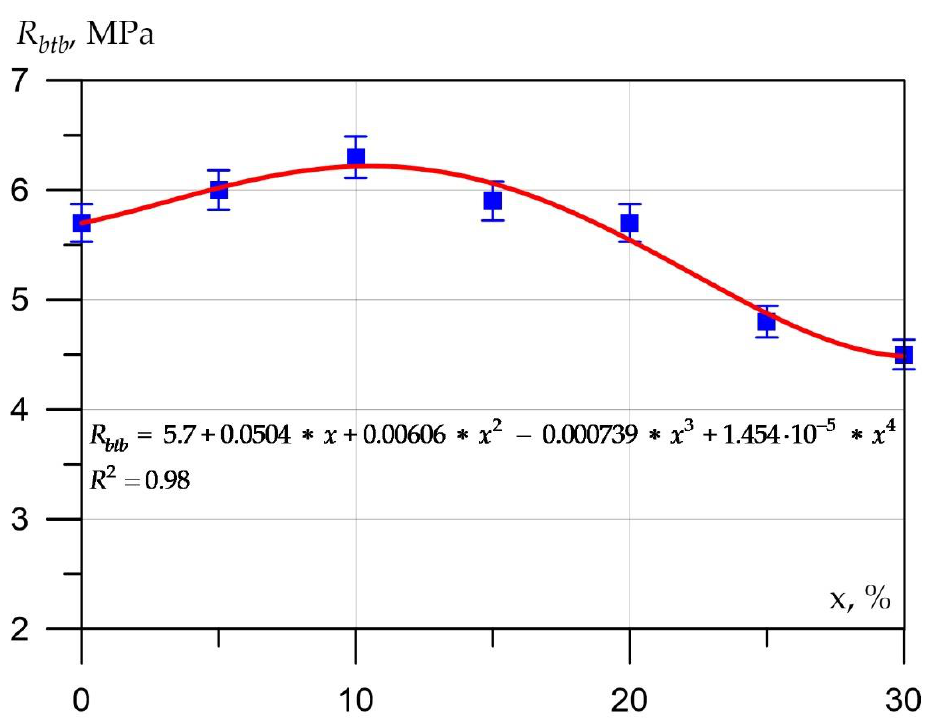
Figure 3. Dependence of the tensile strength in bending of concrete on the amount of eggshell powder.